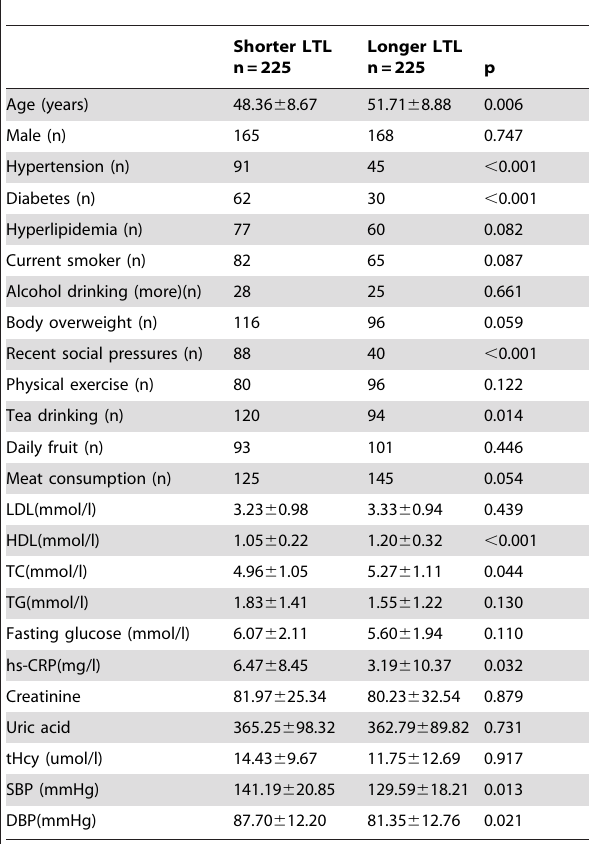
Table 2. Correlations of lifestyle and laboratory parameters with LTL.